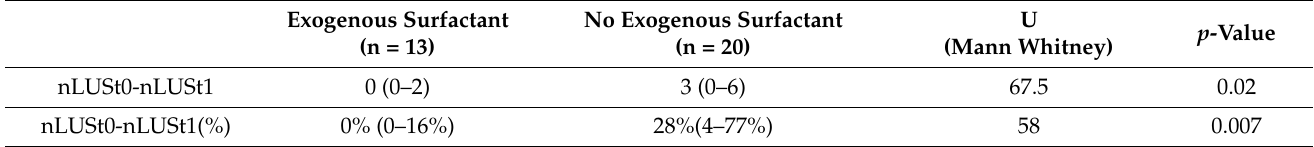
Table 3. nLUS reduction.